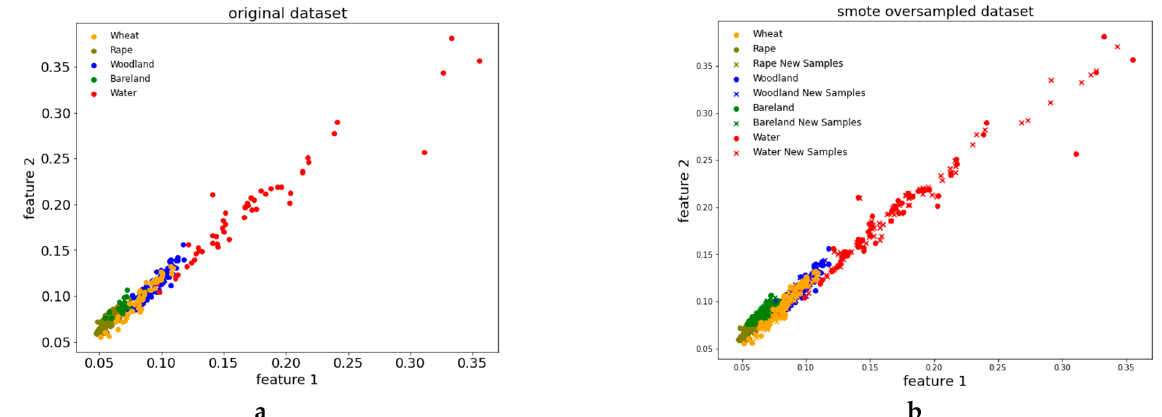
Figure 6. ( a ) origin datasets, ( b ) using oversampling technology in land use